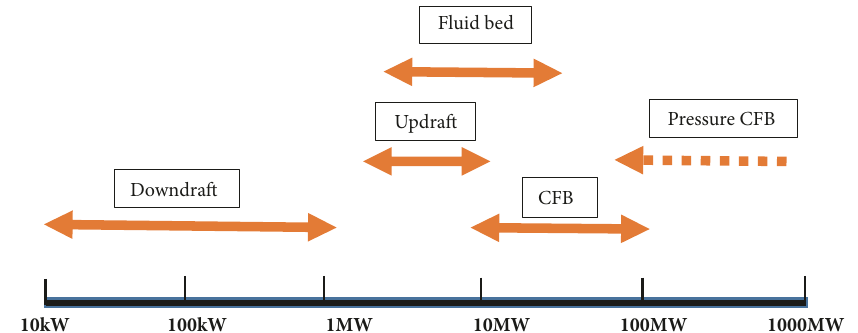
Figure 6: Potential energy generation of different gasifiers. Source: UK Biomass Strategy [3]. Th er m al : 1 kg of fossil fuel replaced by 3.5 kg of biomass. P o w er : biomass consumption, 1.0–1.4